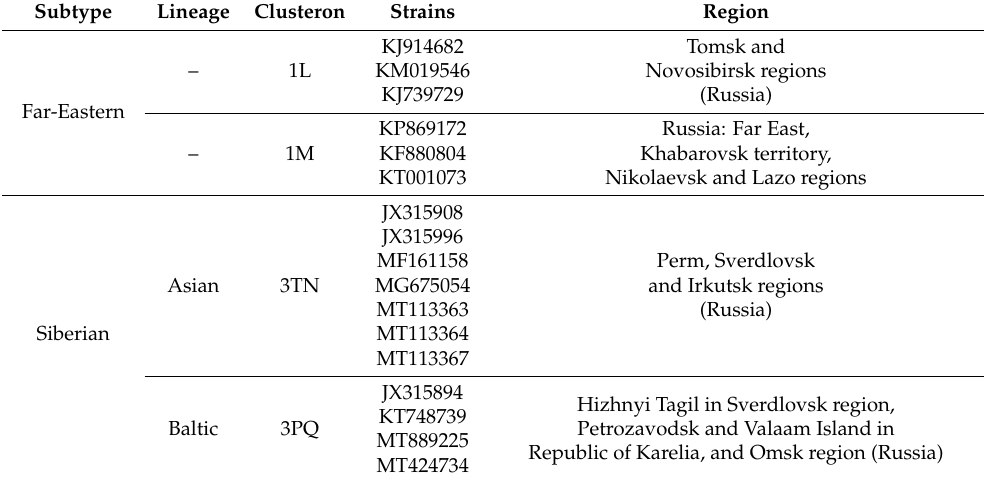
Table 2. Characteristics of new analyzed clusterons. The majority of them belong to European subtypes. The associated accession numbers of each clusteron are presented. The clusteron region is determined through information available in